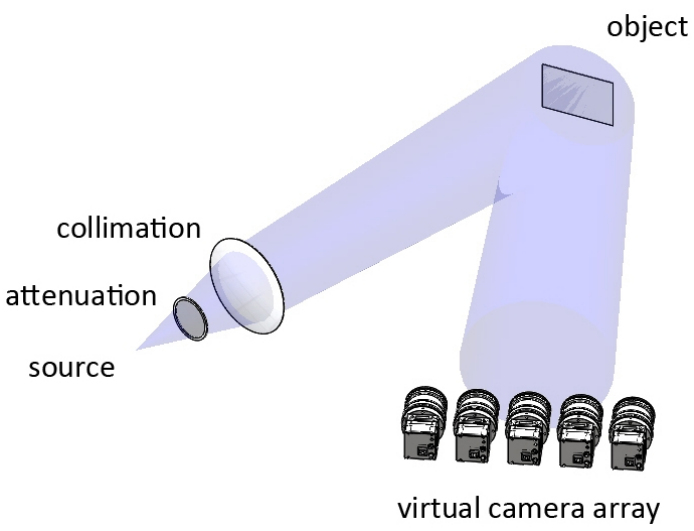
Figure 5. System setup of the reflection-type active illumination terahertz LFI system.